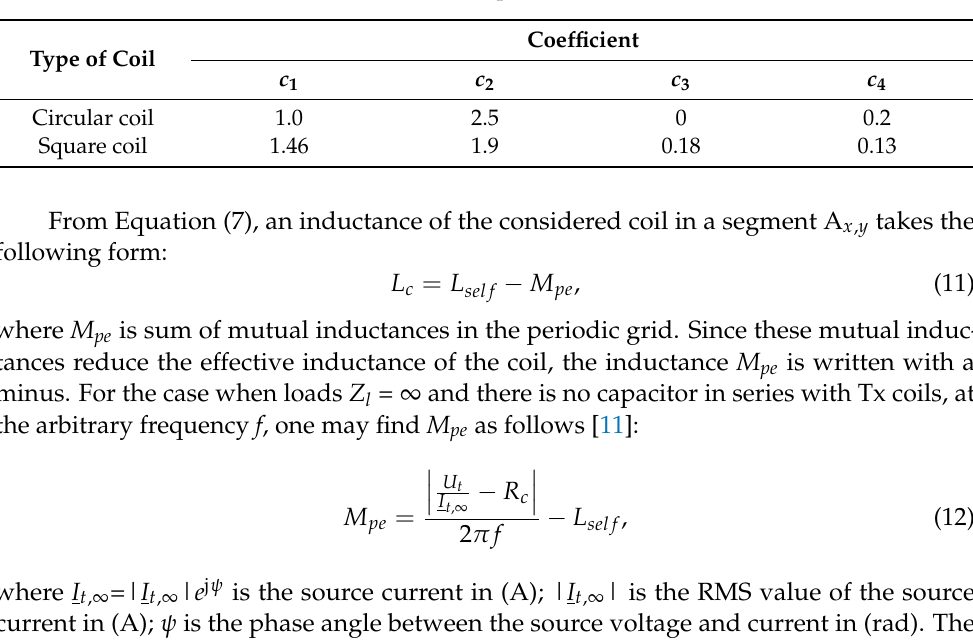
Table 1. Geometrical coefficients for circular and square coils